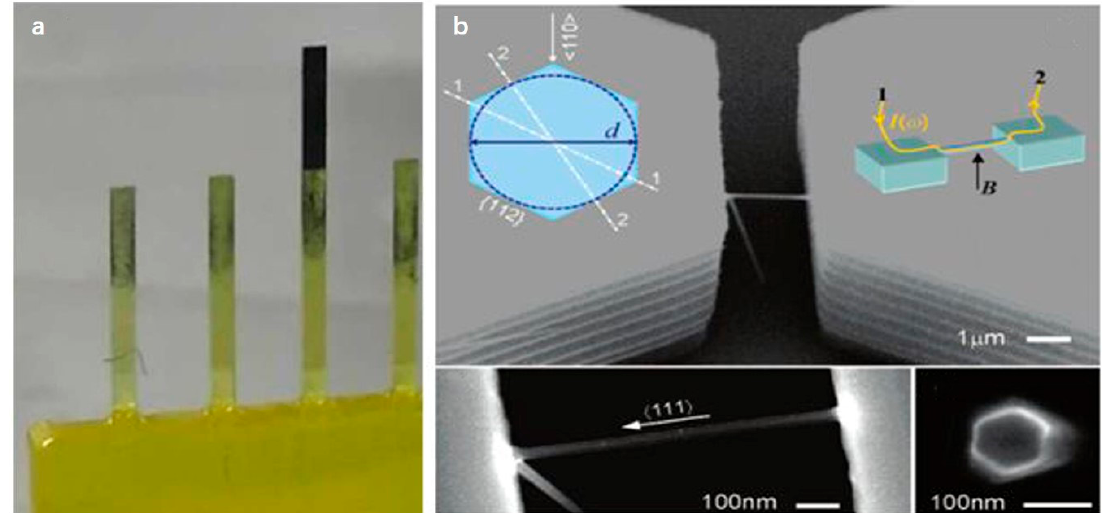
Figure 2. SEM image of single/double-clamped resonator. ( a ) Polymeric cantilevers (width 600 µm). Adapted with permission from [42]. ( b ) Silicon nanowires grown in micro trenches. Bottom left image: nanowires with a width of 600 nm are epitaxially grown along the <111> direction; bottom right image: hexagonal cross-section of silicon nanowire. Adapted with permission from [32].